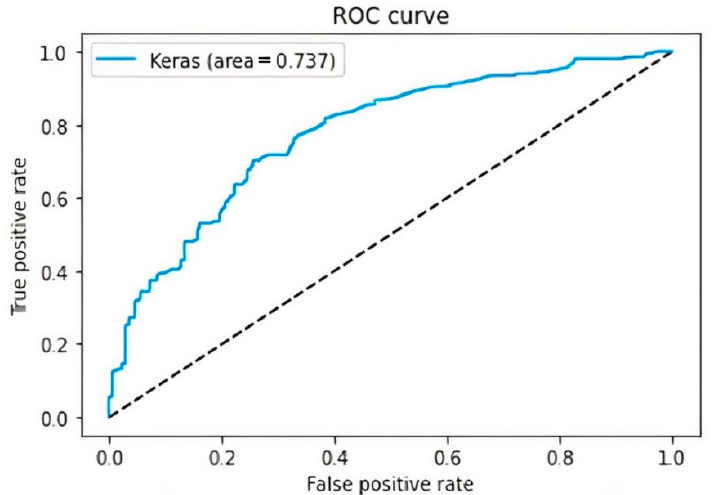
Figure 9. The receiver operating characteristic (ROC) curve for the 13th CNN architecture. The area under the curve (AUC-ROC) is calculated to be 0.737 units.